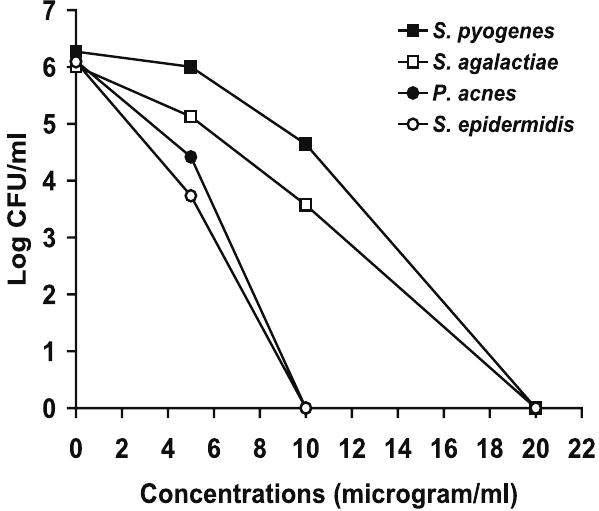
Figure 4. Effects of HT61 against stationary phase non- multiplying S. pyogenes , S. agalactiae , S. epidermidis and P. acnes . HT61 was added to the non-multiplying cultures at 20, 10, 5 and 0 m g/ml. CFU counts were carried out after 24 hours of incubation. These results were confirmed in two independent experiments. doi:10.1371/journal.pone.0011818.g004 PLoS ONE |